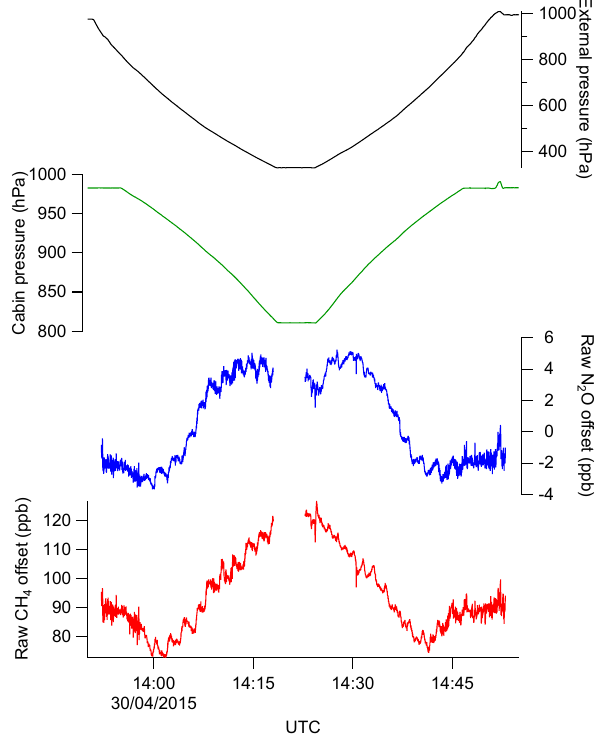
Figure 8. Time series from flight B903, showing the offset between the raw retrieved QCLAS mole fractions and the known content of the target cylinder being sampled. Cabin pressure and external static pressure are also shown to illustrate the systematic nature of the offset during two consecutive